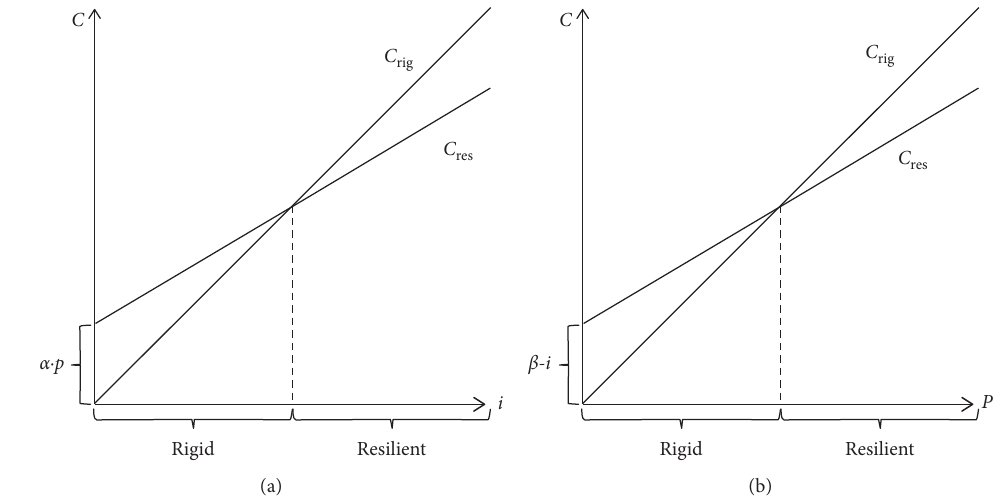
Figure 8: Analogy of the final fees of adamant with resilient SCs. Source: authors. Table 13: t -test for the first hypothesis.